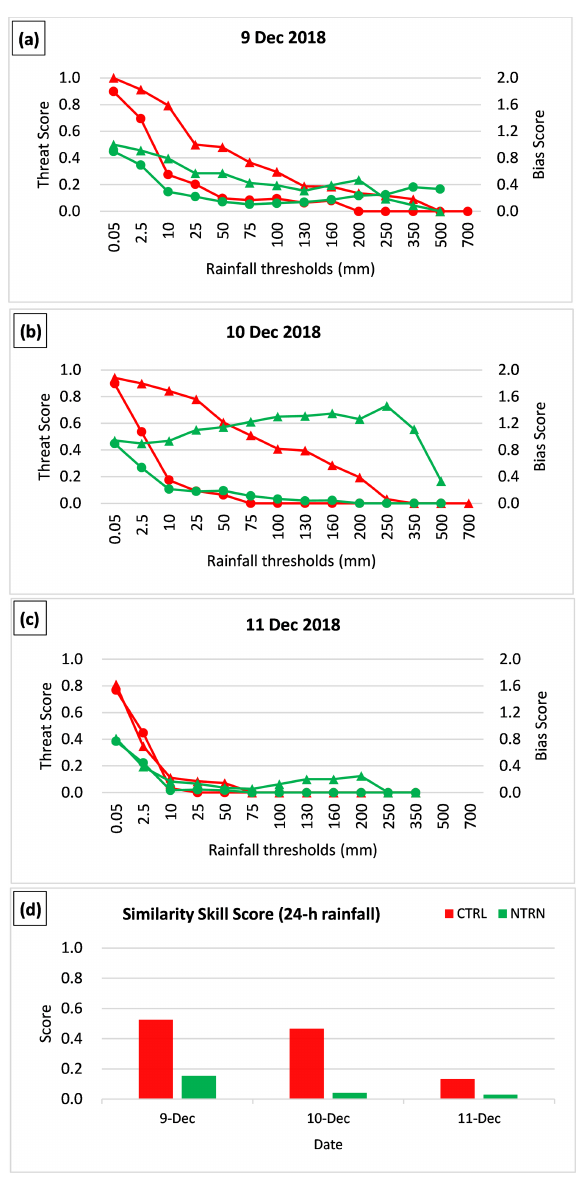
Figure 13. (a–c) The threat scores (red) and bias scores (green) of 24h accumulated rainfall for the CTRL (curve with triangles) and NTRN (curve with dots) experiments for the 3d of 9–11 December 2018. (d) Similarity skill score (SSS) of 24h accumulated rainfall for the two